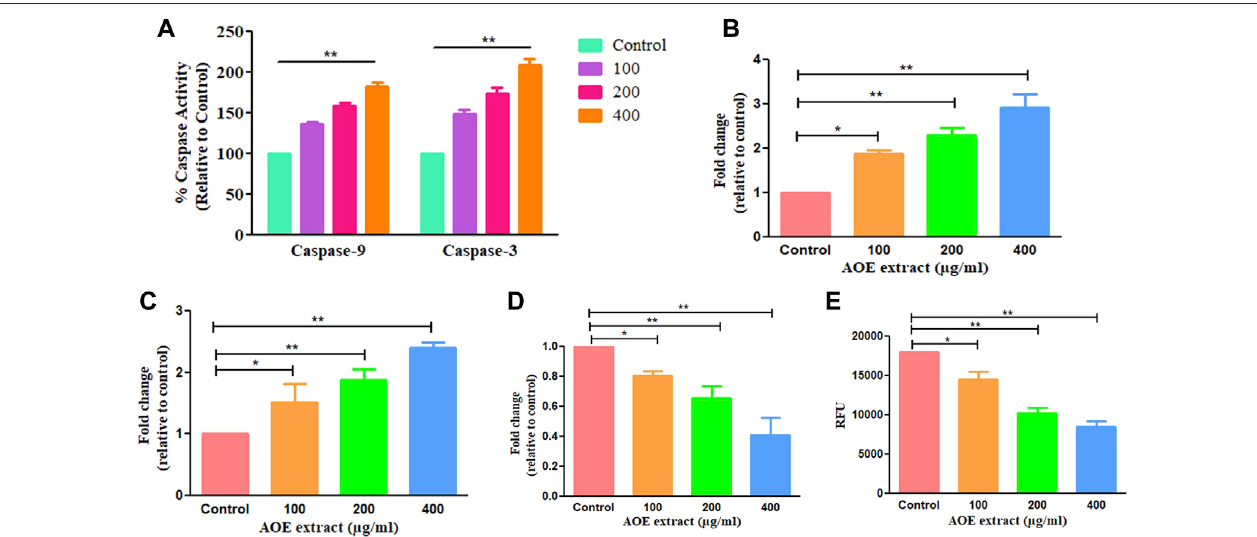
FIGURE 4 | AOE treatment-induced consequences on activation of caspase-9 and -3 within A549 cells (A) percent (%) activation of caspase-9 and -3 activities post AOE exposure at 100 – 400 µg/ml concentrations, (B-E) mRNA expression levels of pro- and anti-apoptotic genes within AOE-treated A549 cells. (E) Decrease in NIR fl uorescence in AOE-treated cells after staining with Mito-NIR dye, suggesting depolarization of ΔΨ m